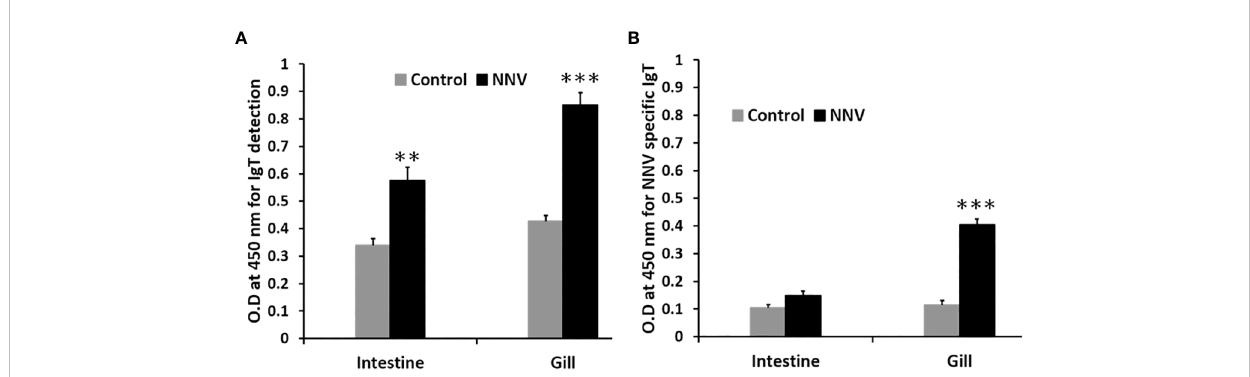
FIGURE 8 Comparison of total IgT and NNV-speci fi c IgT levels in the gill and intestine of control and ASB infected with RGNNV. (A) Total mucosal IgT antibody level was determined by antigen capture ELISA. (B) NNV-speci fi c IgT antibody level was determined by indirect ELISA. Infection was performed by immersion of ASB with 10 5 TCID50 of RGNNV, the organs were collected 14 days post-infection for analysis. Data is a representative of the mean ± SE of 6 fi sh (**, P<0.01; ***,